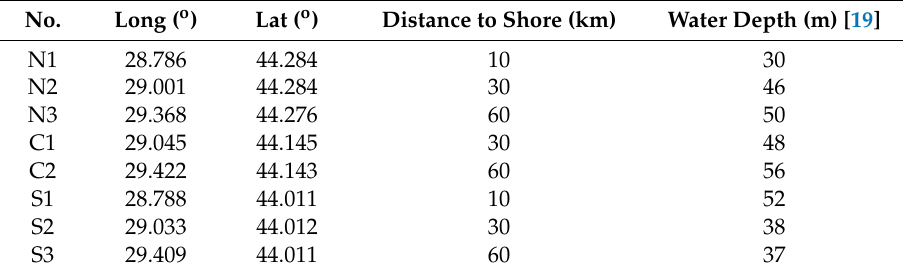
Figure 1. Constanta nearshore and the reference sites considered for evaluation. The red points are used to highlight the roadstead sector of Constanta harbour. Figure processed from Google Earth (2020). Table 1. Main characteristics of the Constanta sites Table 1. Main characteristics of the Constanta sites considered.